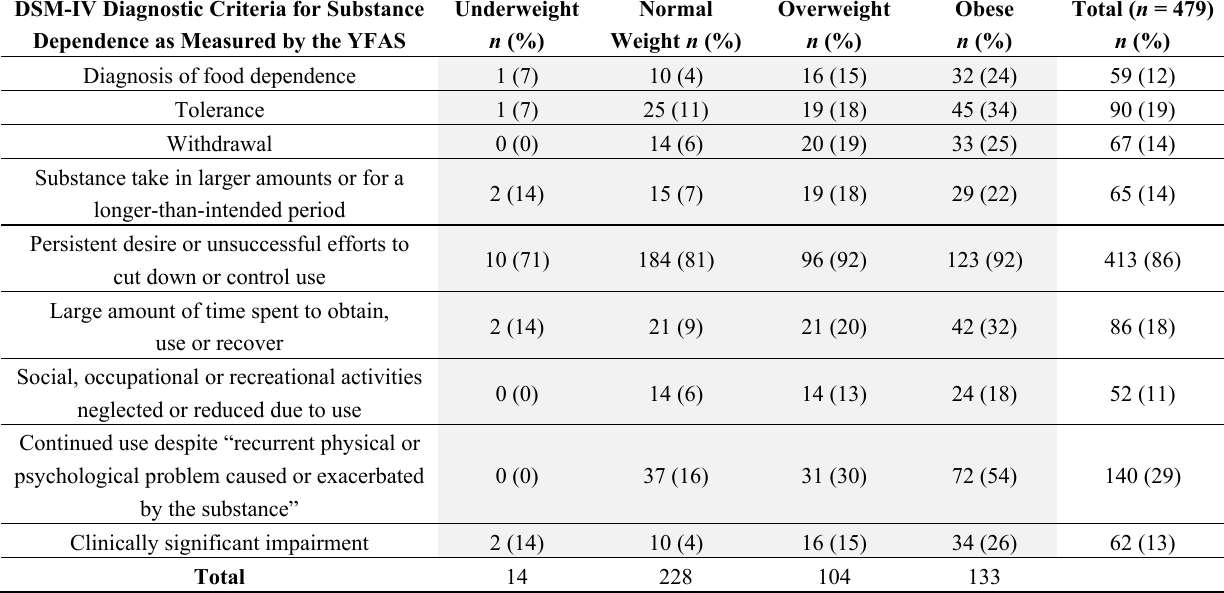
Table 3. Diagnosis of food addiction based on criteria and body mass index (BMI). DSM-IV, Diagnostic and Statistical Manual of Mental Disorders, 4th edition; YFAS, Yale Food Addiction